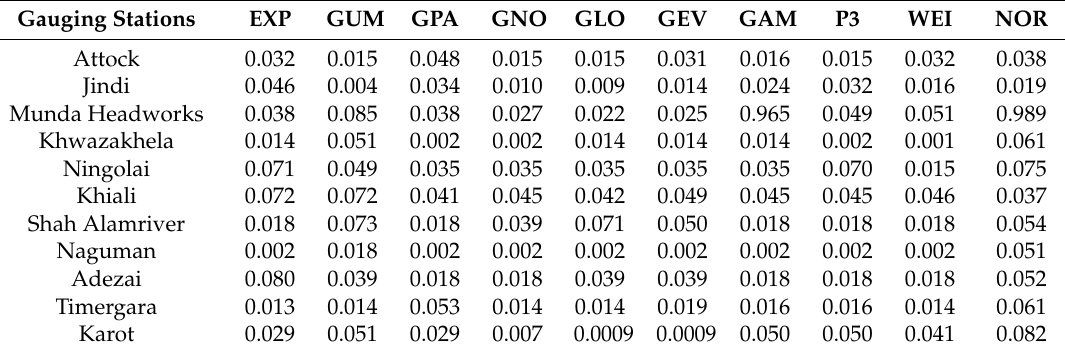
Table 3. Computed p -values of contending distributions for the selected